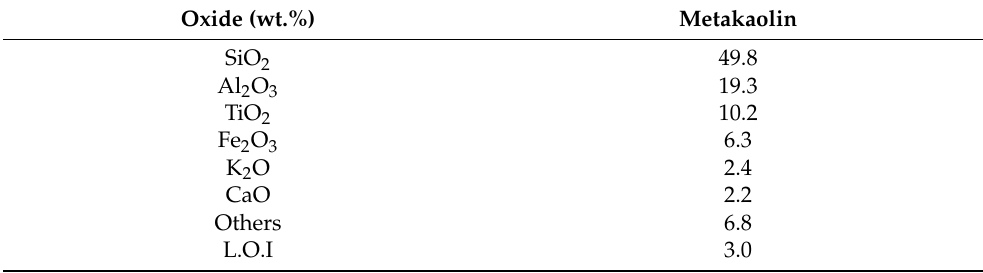
Table 1. Chemical composition of